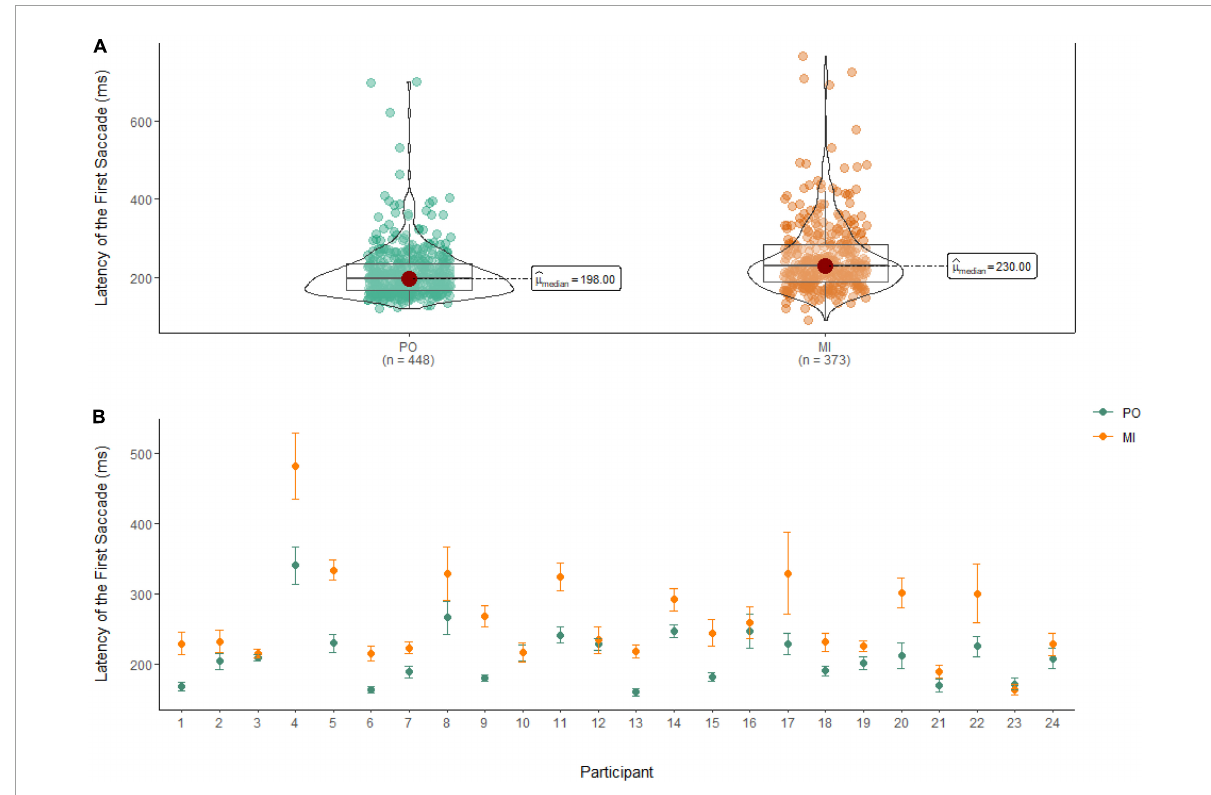
FIGURE8 (A) Differences in the latency of the first saccade between PO (left) and MI (right). (B) The average latency of the first saccade for PO (blue) and MI (orange) is displayed for each of the 24 participants enrolled in the experiment. Error bars are standard error of the mean.